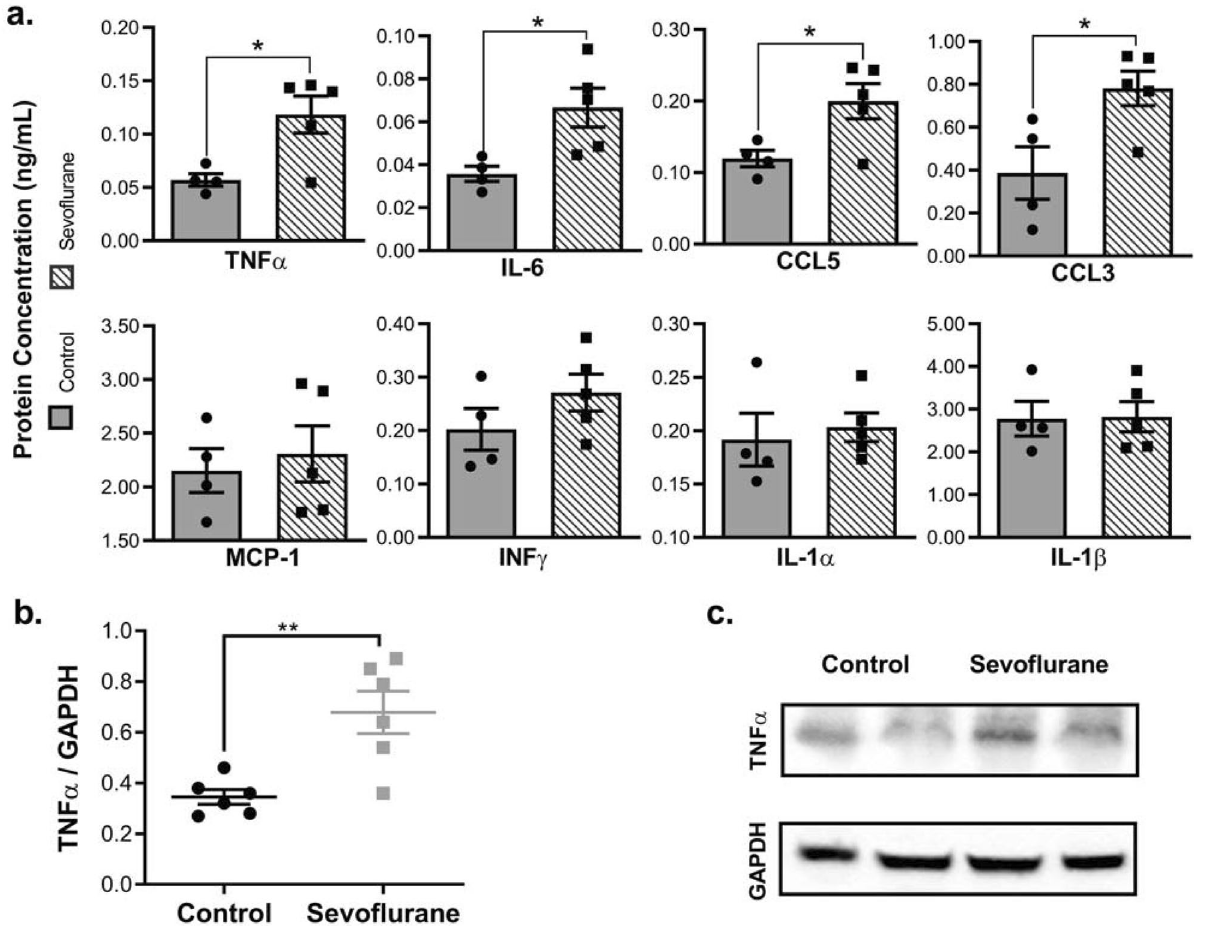
Figure 7. Early developmental exposure to sevoflurane increases the abundance of inflammatory cytokines in cortical rat tissue. Sevoflurane exposure increased the level of neuroinflammatory markers by ELISA ( a ) and Western blot ( b , c ), compared to controls. Values represent means ± SEM, with 6 animals in each group. Statistical significance between groups indicated with (*) for p -value < 0.05, and (**) for p- value <